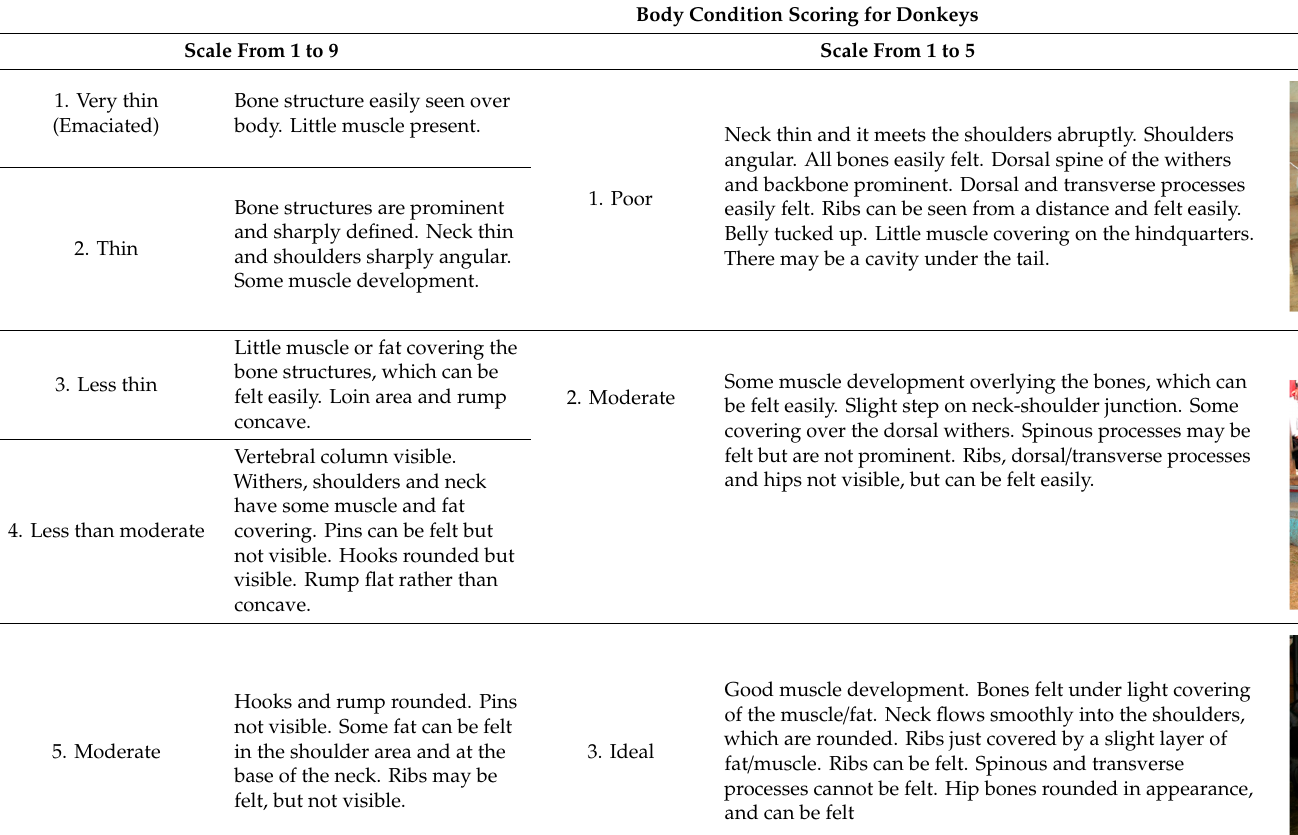
Table 6. Comparison of the two body condition scoring systems for donkeys. Adapted from Pearson and Ouassat [57] and The Donkey Sanctuary [22]. The images in the table are the authors’ own.